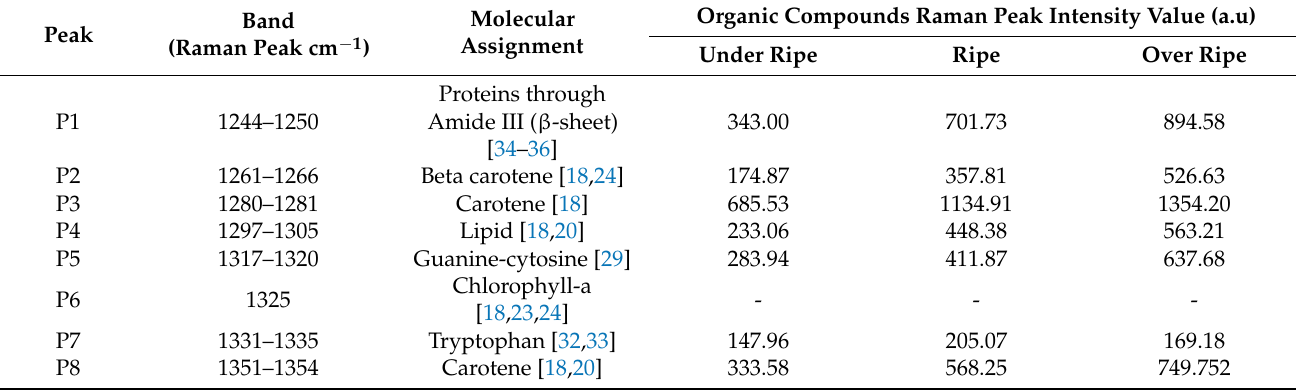
Table 5. Summary of Raman bands and their molecular assignments with intensity values for three oil palm fruit ripening classes for sample B in the range of 1240 cm − 1 to 1360 cm − 1 after spectrum pre-processing and